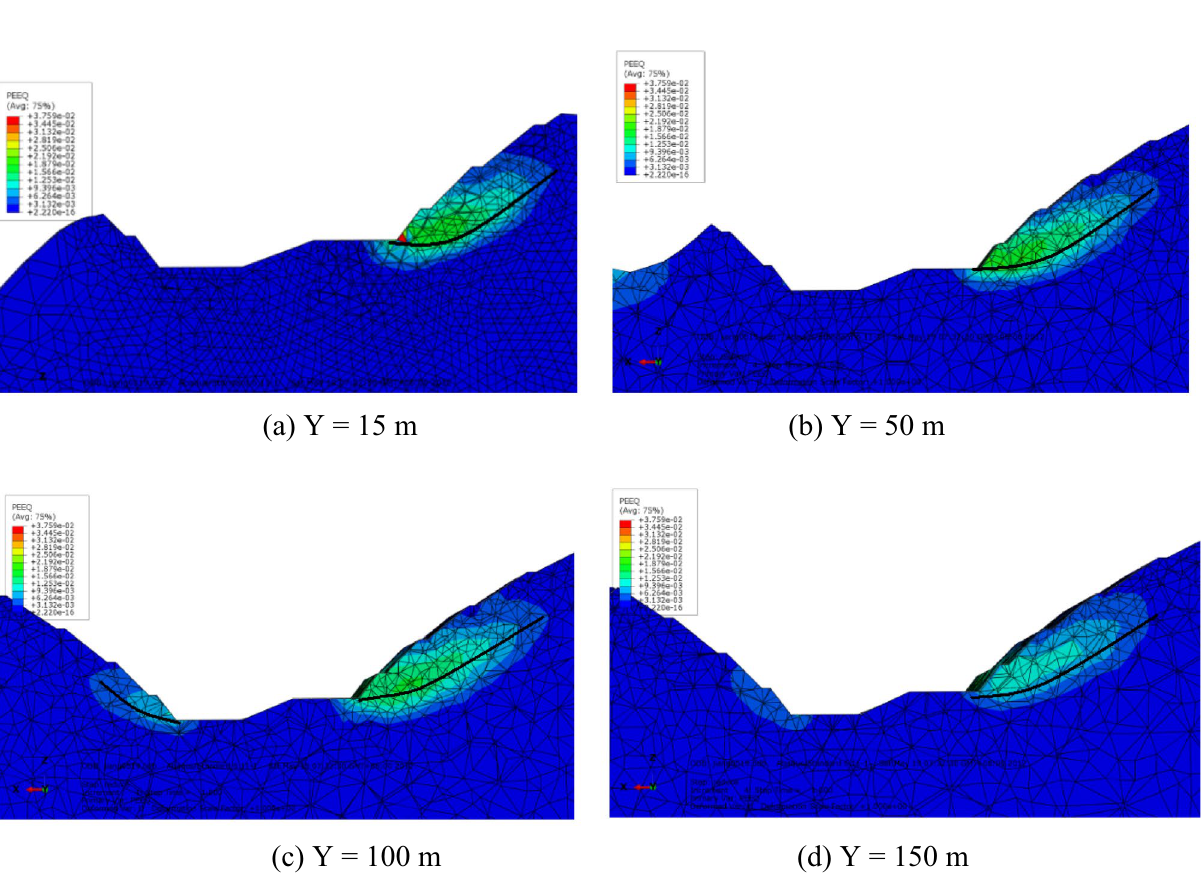
Figure 18. Contour of equivalent plastic strain along the Y